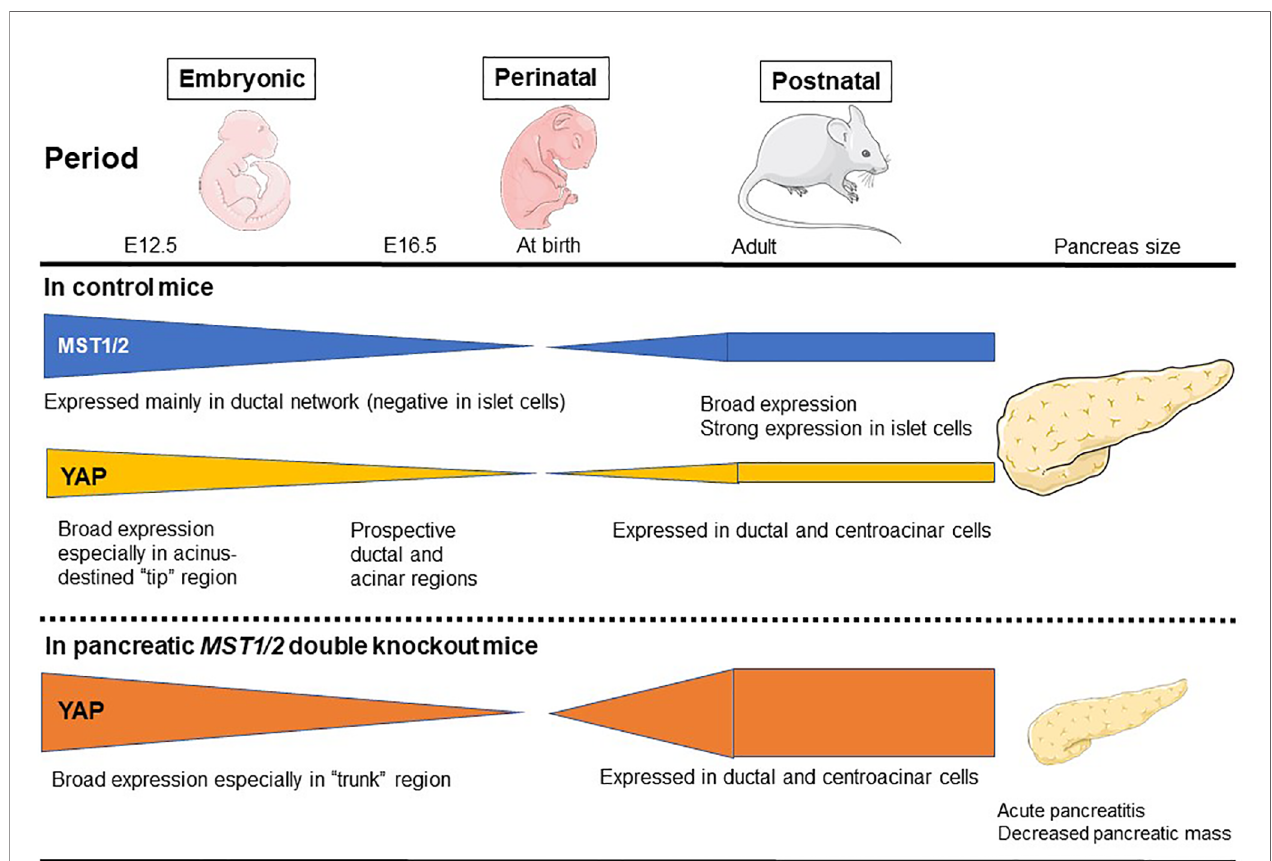
FIGURE 2 | MST1/2 and YAP expression during normal pancreas development. MST1/2 mRNA levels are highest during the embryonic phase and lowest at birth. MST1 mRNA expression reappears at postnatal day 7 and later stages. Phosphorylated MST1/2 expression (active Hippo signaling) is broadly detectable in adult human pancreas, and islet cells display strong expression of phosphorylated MST1/2. YAP is broadly expressed throughout the pancreatic and duodenal E12.5 mouse pancreas (primary transition), but then gradually becomes restricted to prospective ductal and acinar regions at E16.5 (secondary transition). In the adult mouse pancreas, YAP expression is markedly decreased and the strong expression is largely con fi ned to ductal and terminal-duct centroacinar cells, unlike in the embryonic pancreas. In pancreatic MST1/2 double knockout (DKO) mice, nuclear YAP staining is observed in the “ trunk ” regions during the embryonic phase, but is almost undetectable at birth. Thereafter, YAP expression is weak and con fi ned mainly to the ductal compartment at birth and later postnatal stages. In pancreatic MST1/2 DKO mice, abundant YAP expression was observed in abnormally numerous duct-like structures during the postnatal phase. YAP remains undetectable within endocrine cells even in the absence of MST1/2 . Pancreatic MST1/2 DKO mice show the histologic features of acute pancreatitis and decreased size (an approximately 2-fold decrease in pancreas